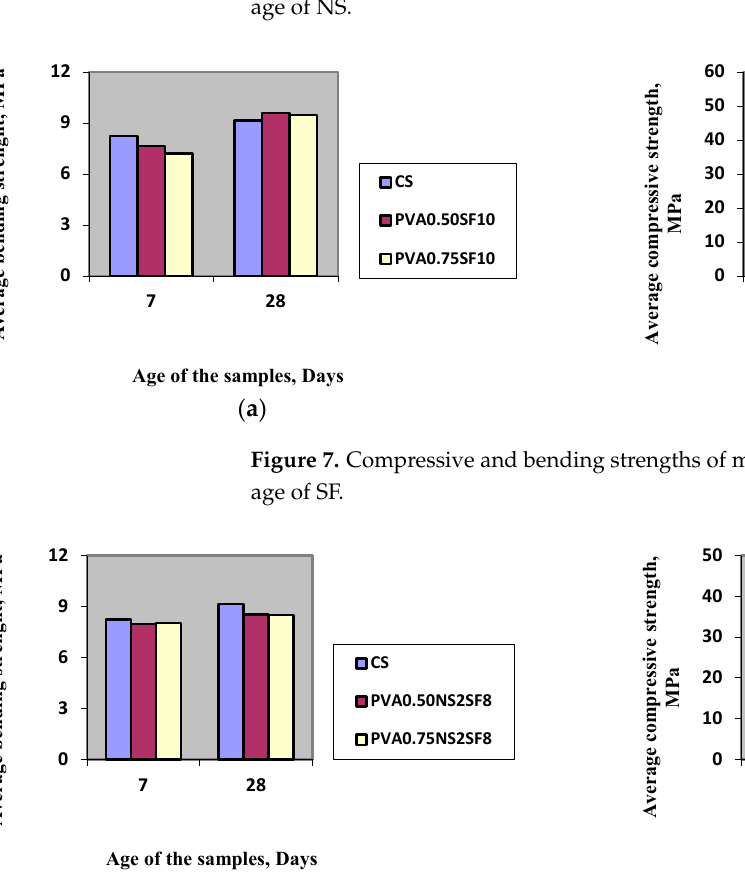
Figure 6. Compressive and bending strengths of mortar containing PVA fiber and optimum percentage of NS.